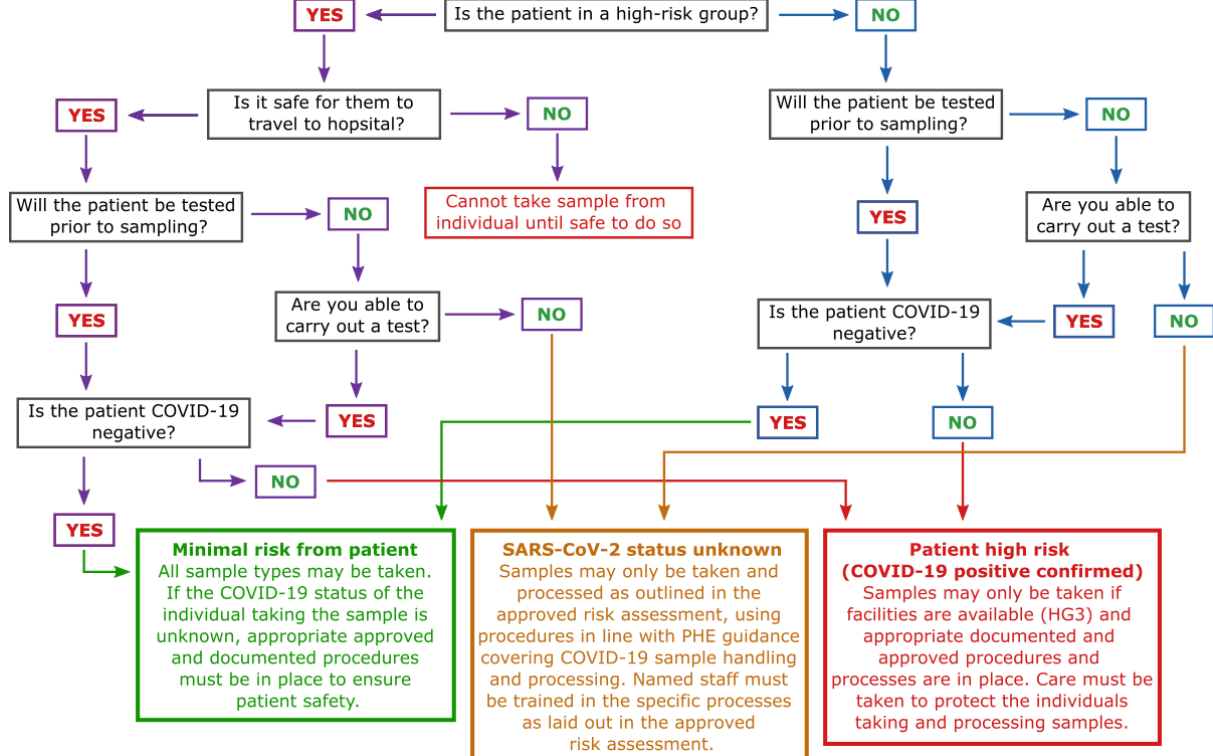
Figure 1. Donor risk flow diagram. Patients are first assessed by phone by a health care professional in the form of a questionnaire. If the patient is unable to be tested for COVID-19, the sample must be processed as status unknown according to Public Health England (PHE) guidance. If the patient can be tested and the test is returned negative, it is safe to assume minimal risk and proceed according to local risk assessments. If the test is returned positive, samples can only be taken if Hazard Group 3 (HG3) facilities are available and proceed according to local risk assessments.